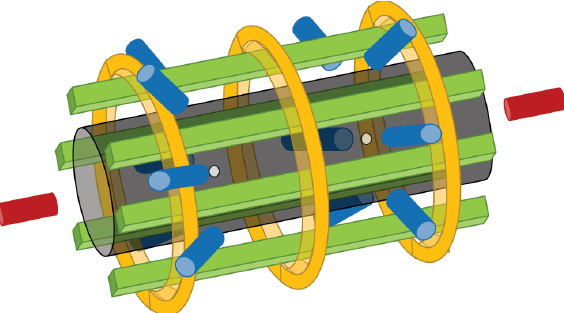
Figure 1. Sketch of the PANDORA’s trap with the magnetic system (coils in yellow, hexapole in green), and the array of 14 cylindrical γ -detectors, 2 placed in the axial line (red) and 12 in the radial one